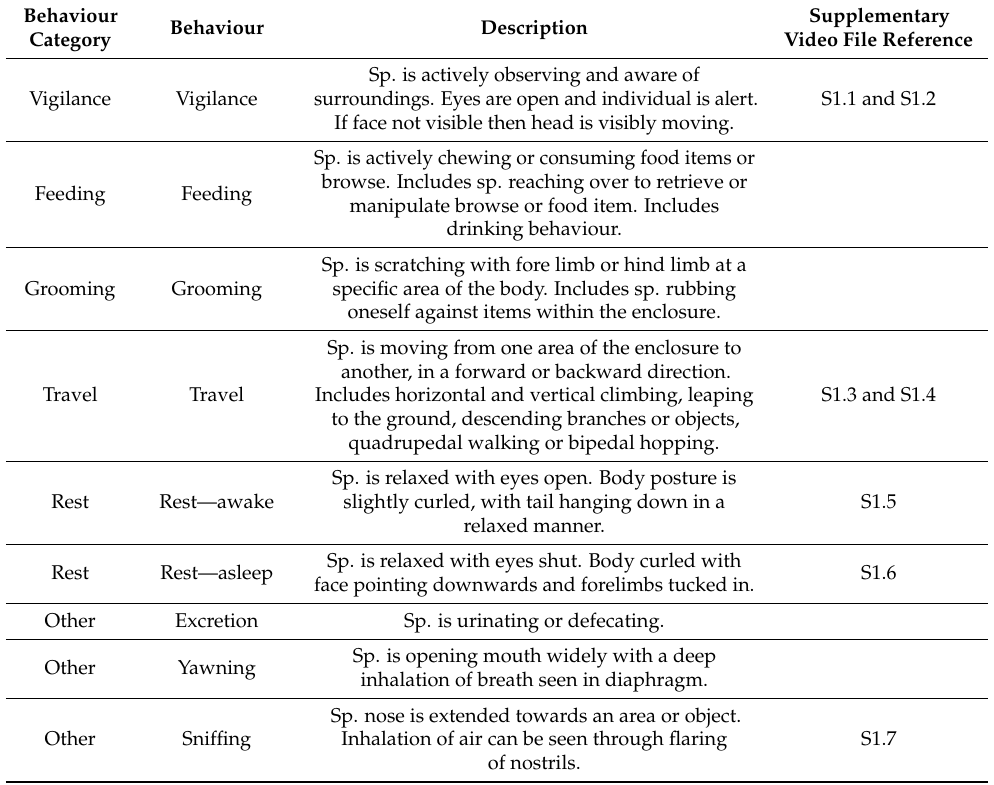
Table 2. Ethogram of behaviours, allocated behavioural category used for data visualisation, full de- scription of behaviour and reference for reader to access supplementary files of behaviour. Ethogram adapted from Dabek